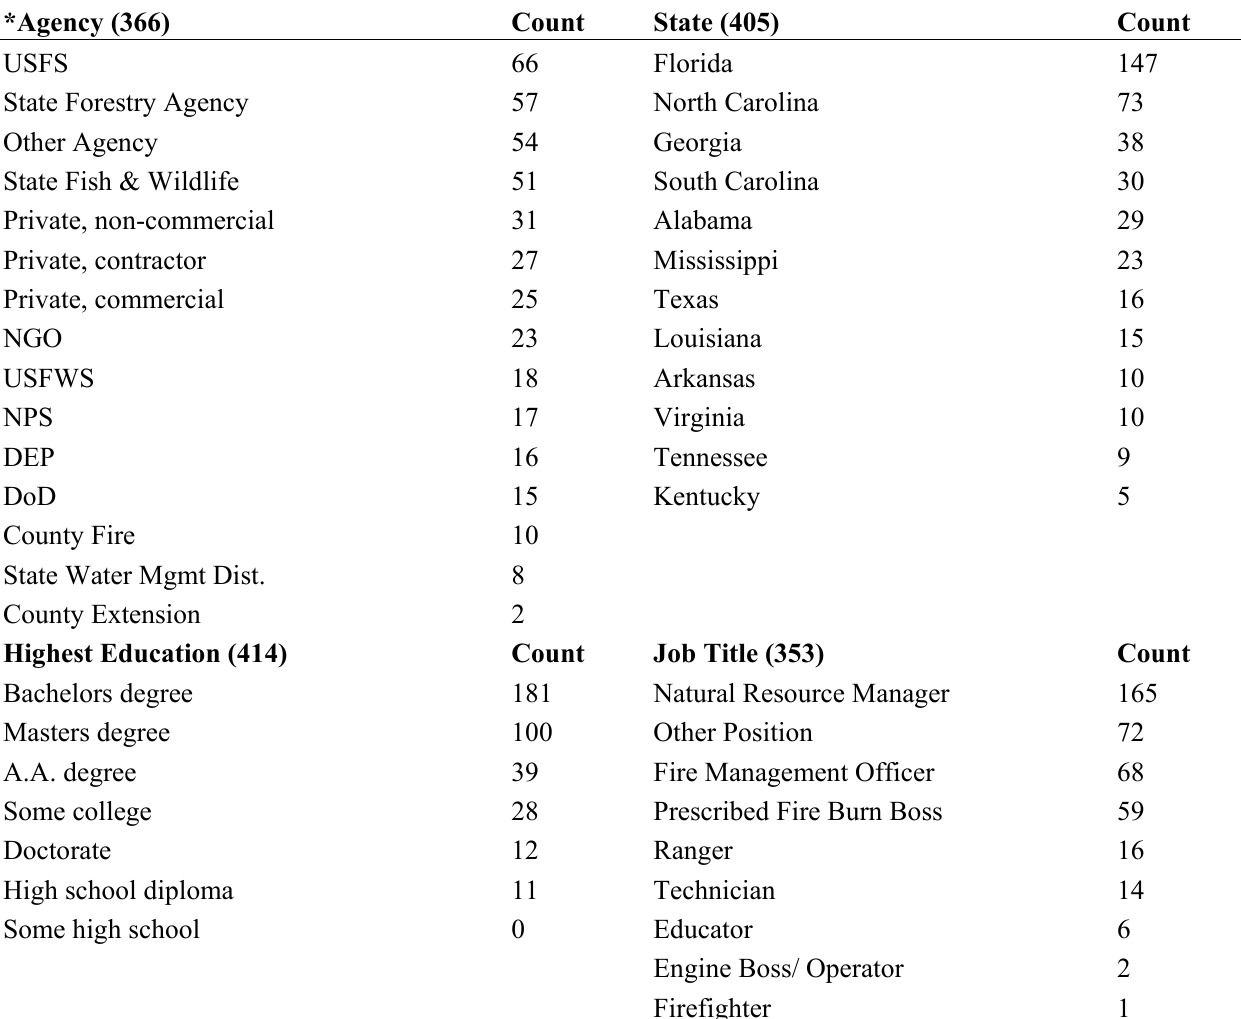
Table 1. Demographics (number of respondents) of survey population, including state where employed, employer, job title, and level of